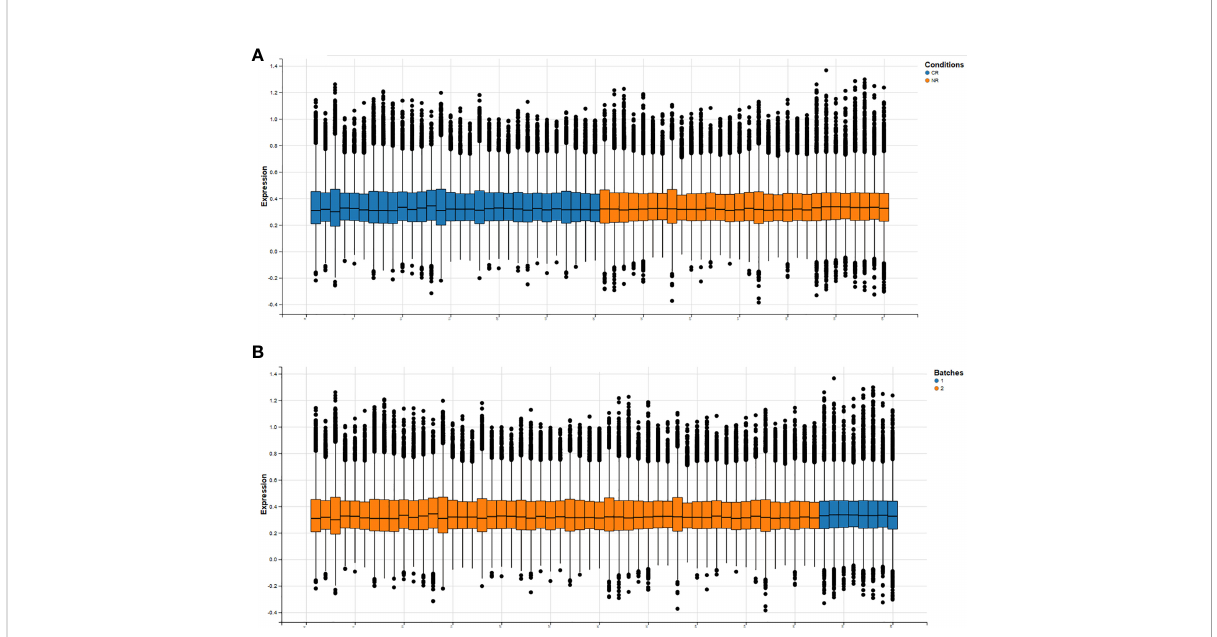
FIGURE 2 Overall expression levels of individual samples after removal of batch effects (horizontal axis is all samples, vertical axis is normalized expression values. (A) shows the expression information of genes in each sample under both conditions, (B) shows the expression information of genes in each sample under both